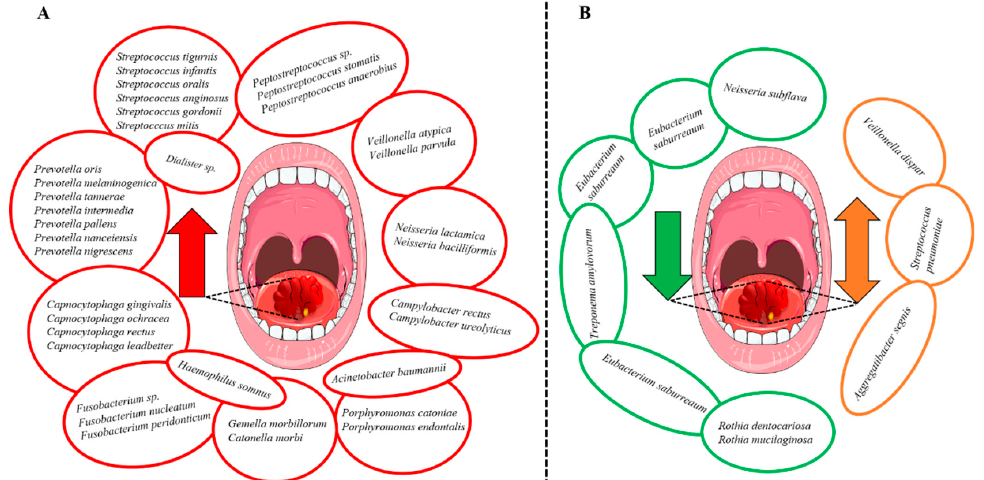
Figure 3. The relative abundance of the studied oral microbiota in oral squamous cell carcinoma (OSCC). ( A ) The bacterial species shown to have a higher abundance in OSCC (red circles; red arrow). ( B ) The bacterial species shown to have a lower abundance in OSCC (green circles; green arrow). In addition, a few species were shown to be increased in some studies and decreased in others (orange circles; orange double-headed arrow).